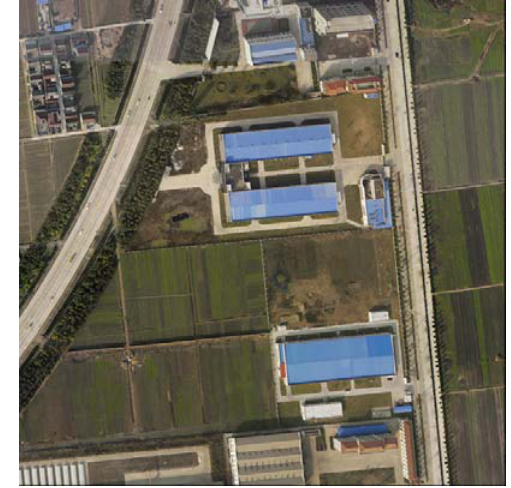
Figure 1. Aerial image of size 626*626